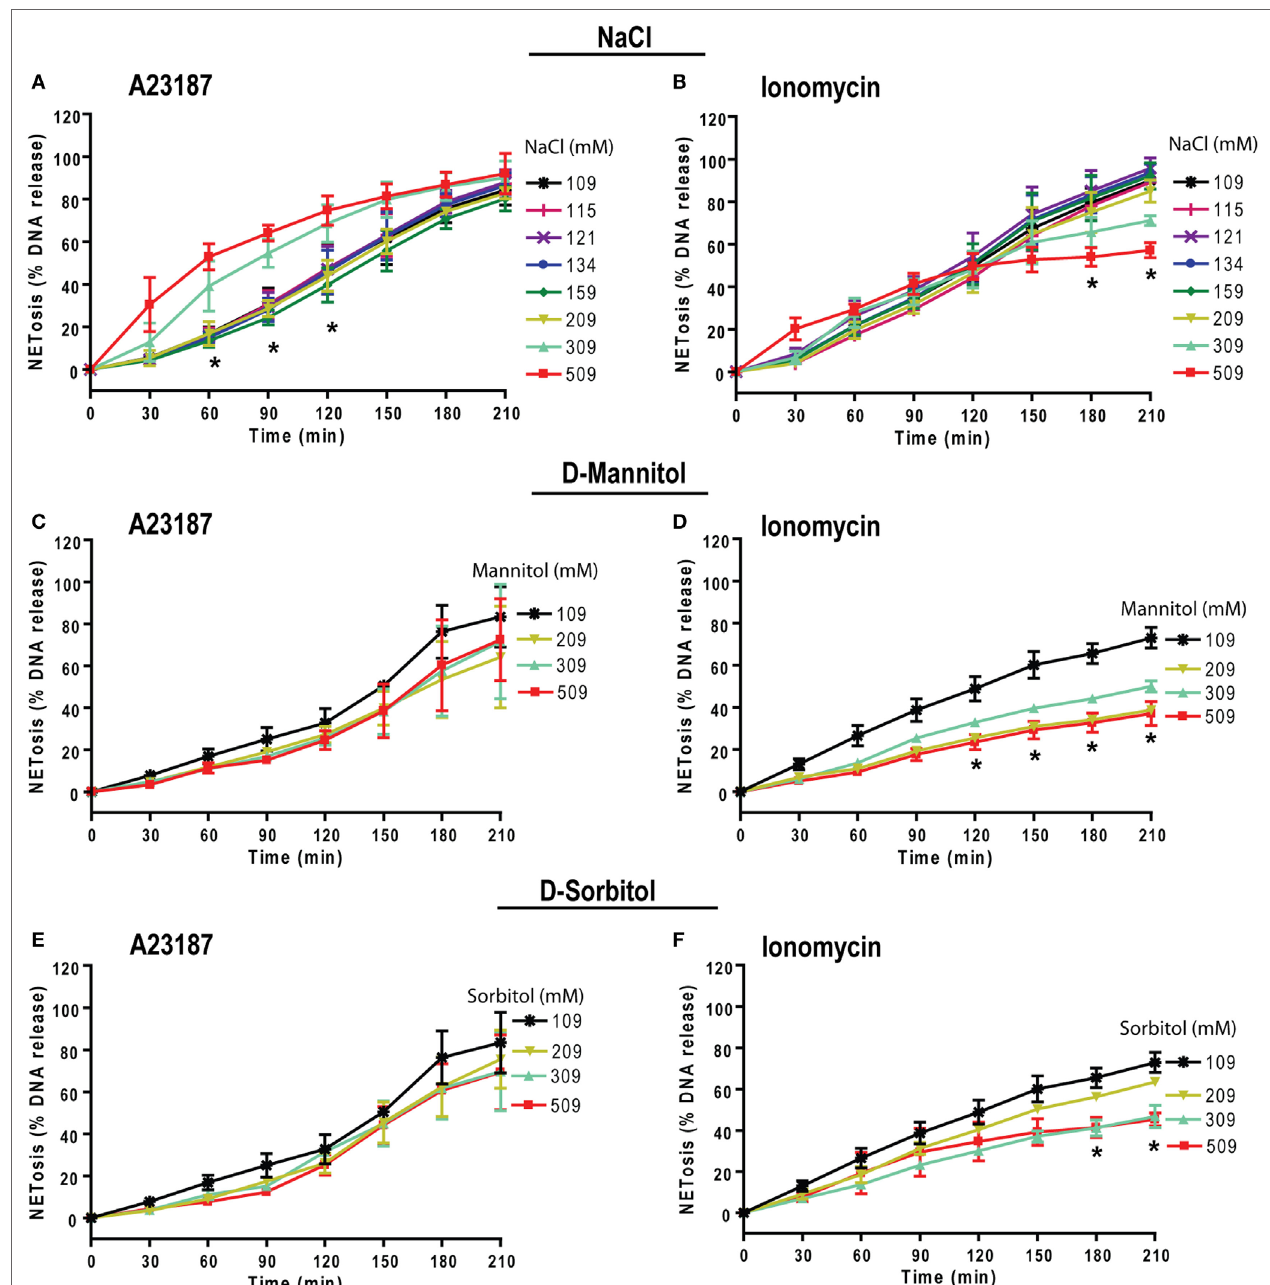
FigUre 8 | Increasing NaCl and osmolytes concentration suppresses ionomycin-induced NETosis. Human neutrophils in different osmolytes (NaCl, d -mannitol, and d -sorbitol) were treated with Nox-independent NETosis agonists A23187 and ionomycin. (a) Initial kinetics of the neutrophils under high concentration showed more NETosis. High NaCl concentrations were not able to suppress NETosis in response to A23187; however, this effect was lost by later time points leading to no overall difference by 210 min. (B) In contrast, ionomycin-induced NETosis show some suppression at later time points. (c,D) Neutrophils treated with different d -mannitol concentrations showed NETosis suppression only in ionomycin activated neutrophils. (e,F) Neutrophils treated under d -sorbitol conditions also show the same suppression pattern as of (c,D) ( n = 3; Two-way ANOVA with Bonferroni’s multiple comparison post